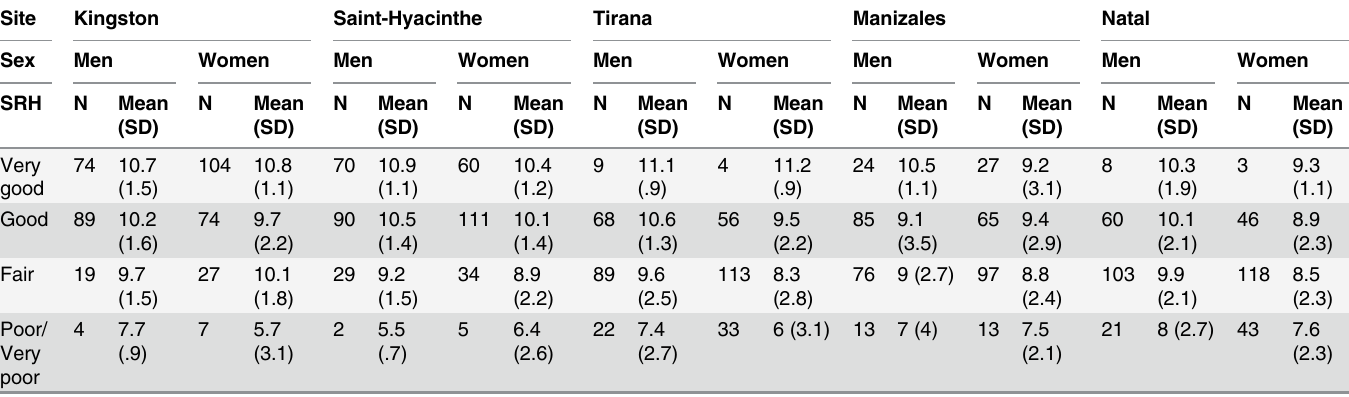
Table 2. Mean (SD) of SPPB † According to Self-Rated Health (Four Categories) at Each Site and Stratified by Sex † .